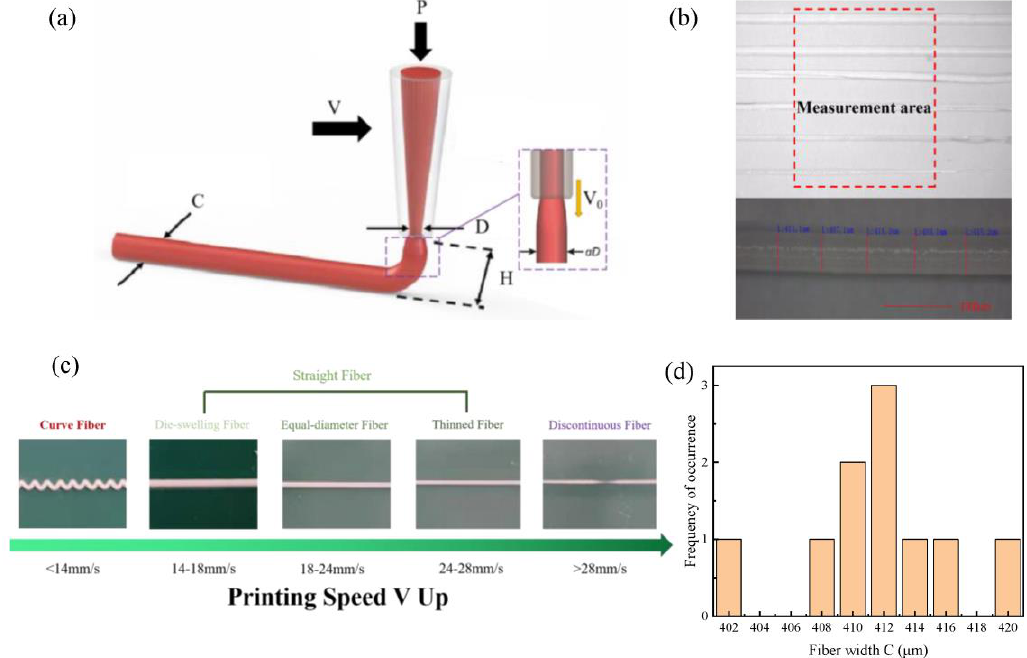
Figure 5. ( a ) Schematic illustration of typical parameters for DIW 3D printing; ( b ) monofilament measurement photos; ( c ) optical photograph of the fiber shape as a function of speed; ( d ) frequency histogram chart.